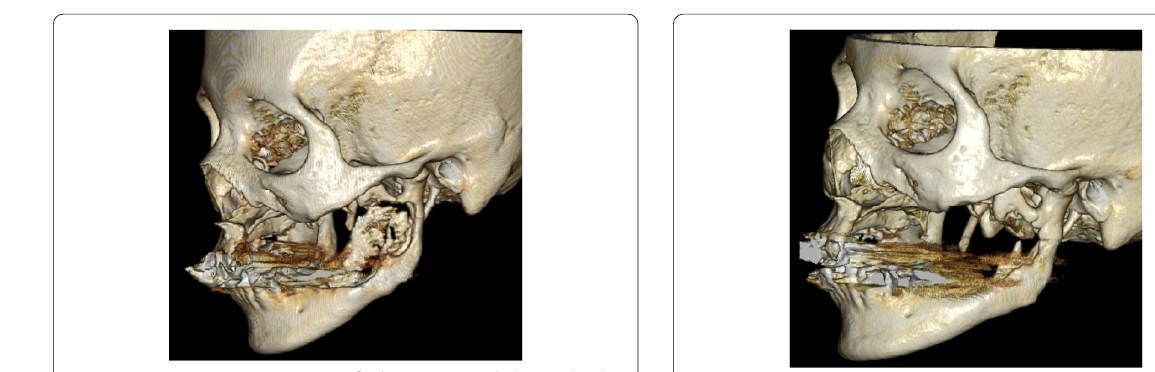
Fig. 6 3D CT imaging findings at 12 months